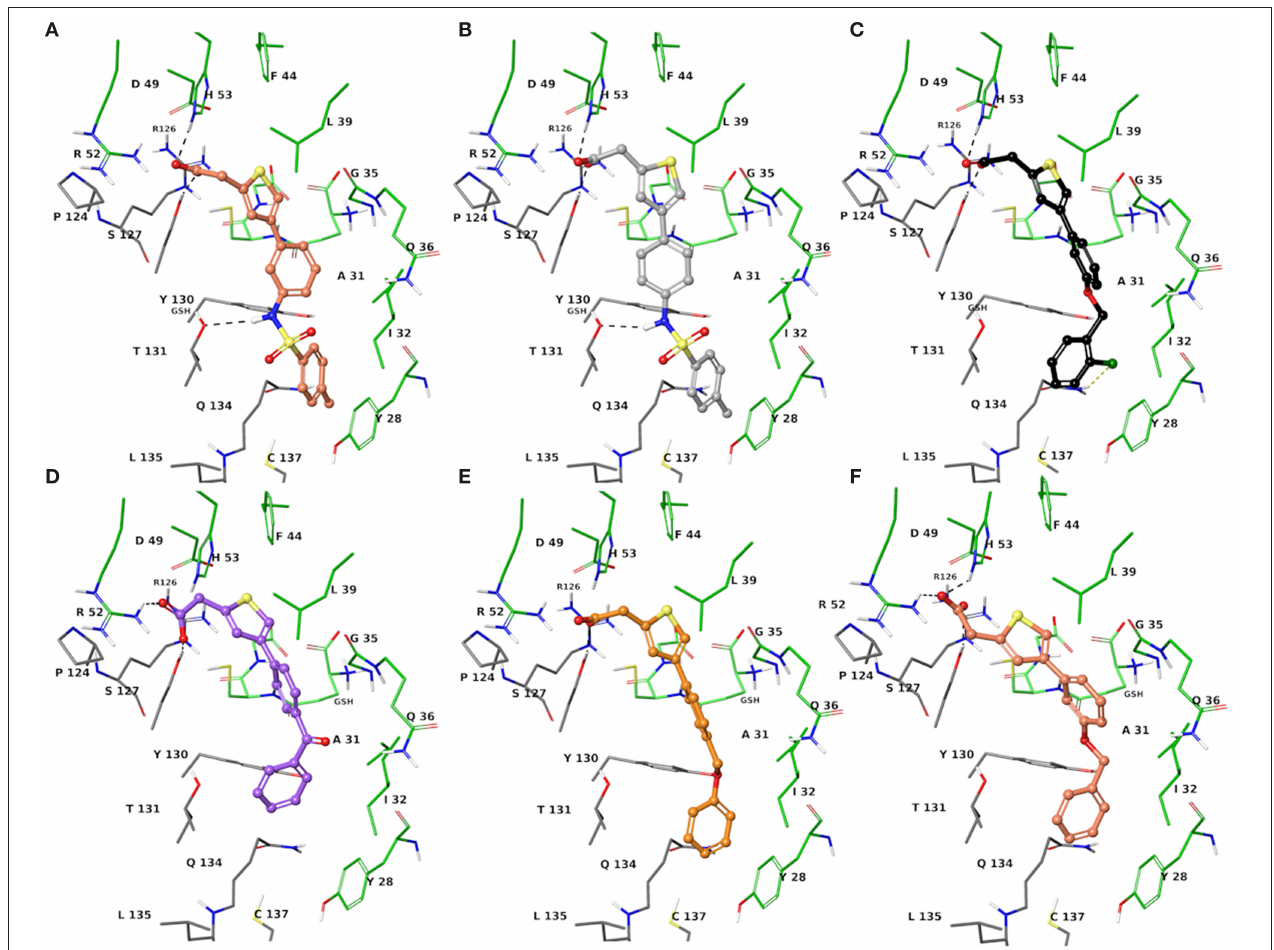
FIGURE 5 | Three-dimensional model of the interactions given by 2a (A) , 2b (B) , 2c (C) , 2d (D) , 2e (E) , and 2f (F) with mPGES-1. The protein is depicted by the tube [colored: C, gray (chain A) and green (chain B); polar H, white; N, dark-blue; O, red; S, yellow]. The GSH is sketched in the faded green tube. The small molecules are represented by sticks (faded salmon for 2a , light gray for 2b , black for 2c , faded violet for 2d , orange for 2e , faded red-orange for 2f ) and balls (colored: C, as for the sticks; polar H, white; N, dark-blue; O, red). The dashed black and yellow lines indicate the hydrogen and halogen bonds, respectively, between ligand and